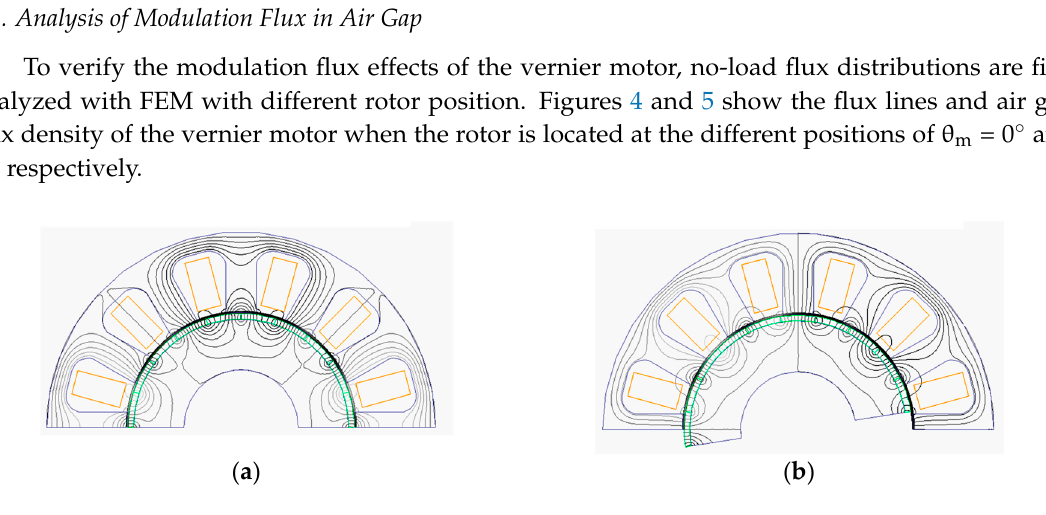
m = 0°; ( b ) when θ m = 9°.